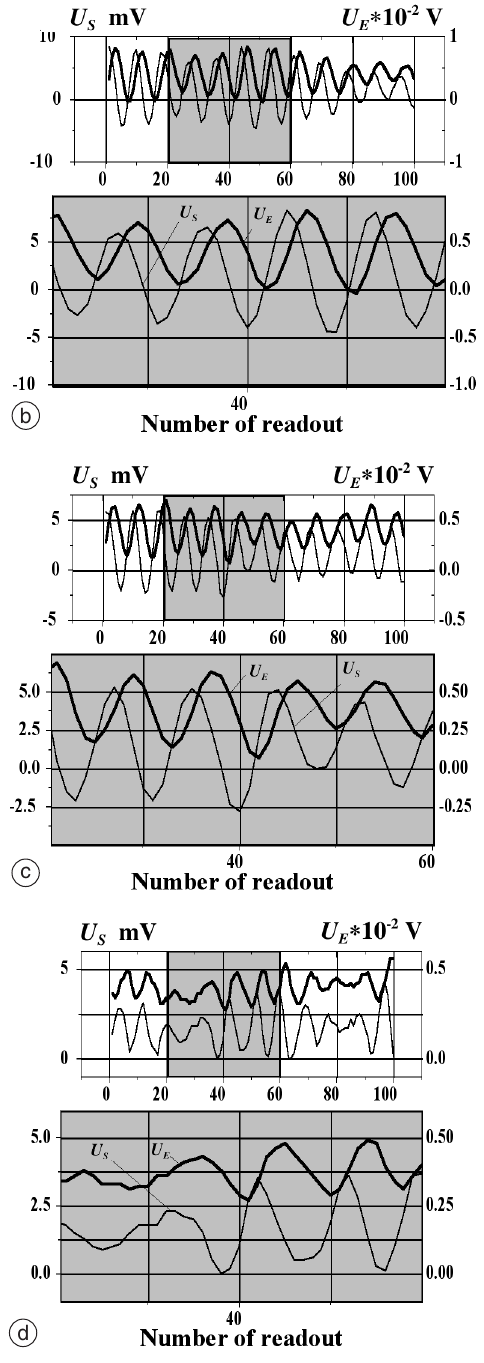
Fig. 9b-d. MSO of the second type. Change in self- oscillations after sample damping. Measurements were executed with 30-40 s intervals: damped sam- ple, electric ( U E ) and acoustic ( U S )